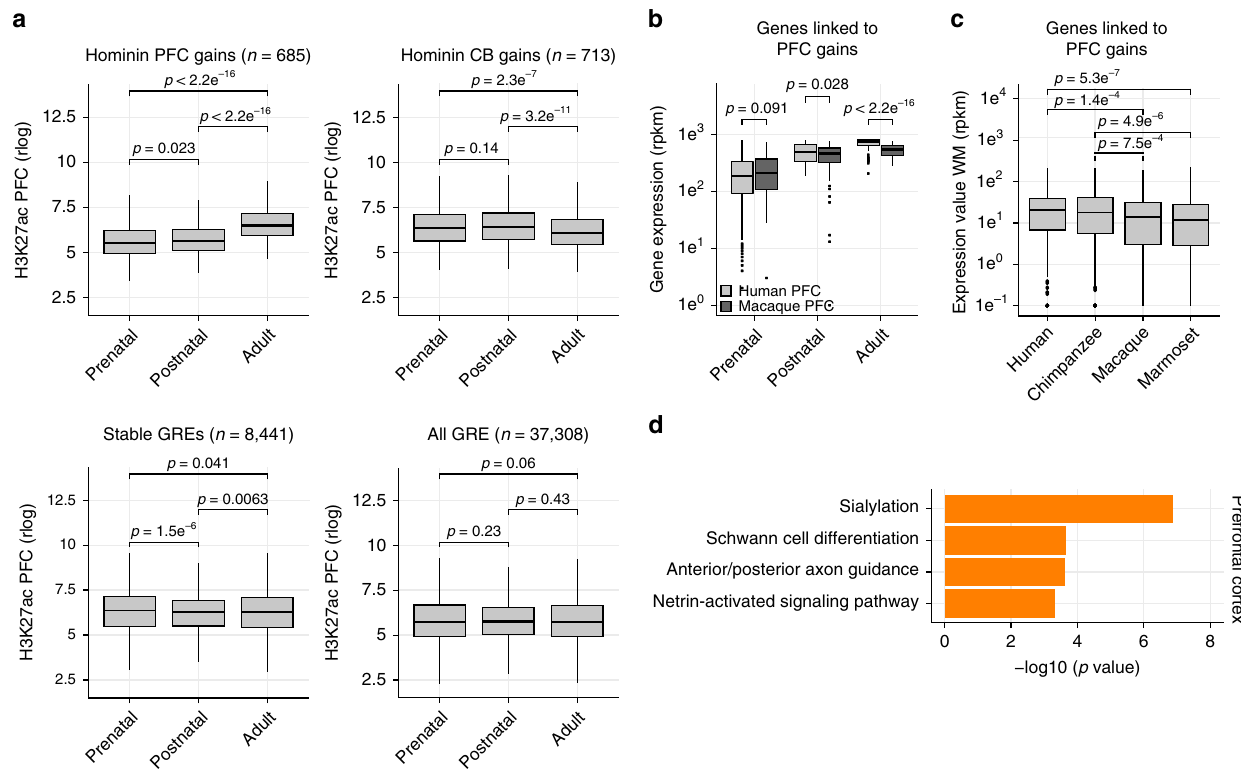
Fig. 3 Hominin-speci fi c gains emerge postnatally. a Box plots showing normalized H3K27ac enrichment in PFC or CB samples across different developmental timepoints for hominin-speci fi c gains, stable GREs and all primate GREs. Dissimilarities between distributions were calculated using a Student ’ s t test. b Box plots showing normalized gene expression values of genes linked to hominin-speci fi c PFC gains across developmental time, for both human and rhesus macaque. Dissimilarities between distributions were calculated using a Student ’ s t test. c Box plots showing normalized gene expression values in the white matter tissue of different primates for genes linked to hominin-speci fi c PFC changes. Dissimilarities between distributions were calculated using a Student ’ s t test. d Gene-ontology analysis using GREAT for hominin-speci fi c PFC gains. P values represent signi fi cance of enrichment for stated biological process. Bottom and top of all box plots are the fi rst and third quartile. The line within the boxes represents the median and whiskers denote interval within 1.5× the interquartile range from the median, outliers are depicted as